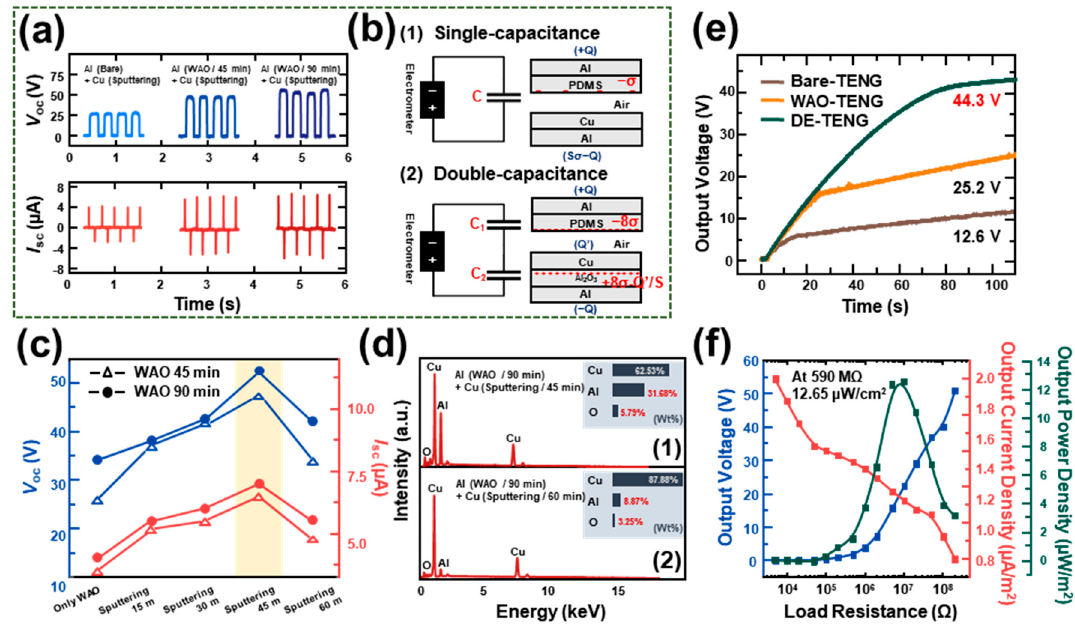
Figure 3. The electrical output from the DE-TENG compared to the pristine TENG: ( a ) The electrical output tendency ( V oc and I sc ) and ( b ) the schematic structure of ( b1 ) single and ( b2 ) double capacitance; ( c ) the electrical output tendency of WAO-TENG and DE-TENG under various sputtering times; ( d ) the EDAX data for the DE-TENG (sputtering under ( d1 ) 45 and ( d2 ) 60 min); ( e ) output voltage from charging of a 0.1 µ F capacitor (bare-TENG, WAO-TENG, and DE-TENG); ( f ) output power density, output voltage, and output current density along the load resistances.